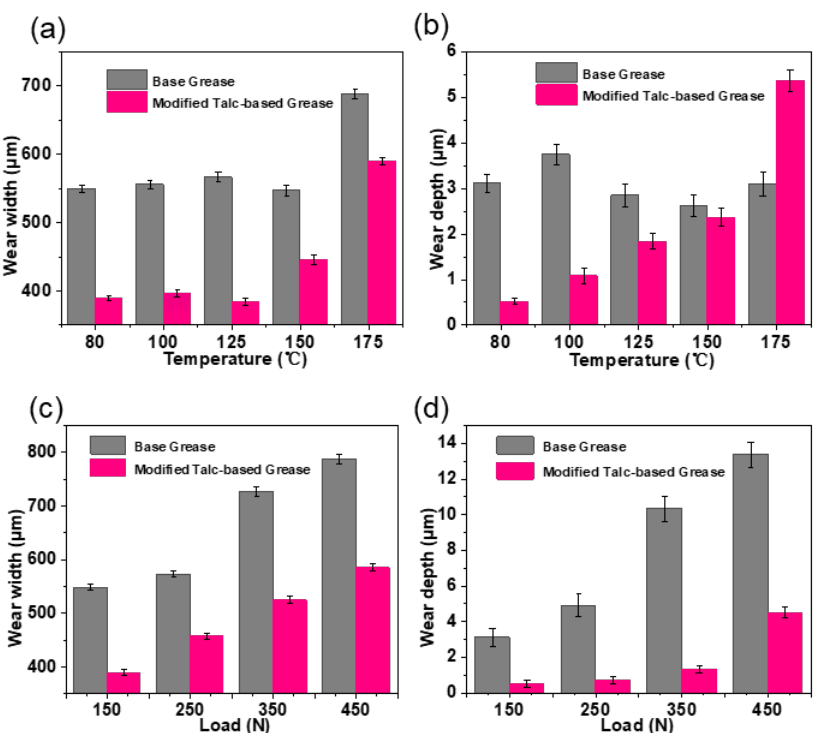
Figure 7. The anti-wear performance of the modified talc-based grease (0.5 wt.%): wear width ( a ) and wear depth ( b ) at different temperature (150 N); wear width ( c ) and wear depth ( d ) under different loads (80 °C).